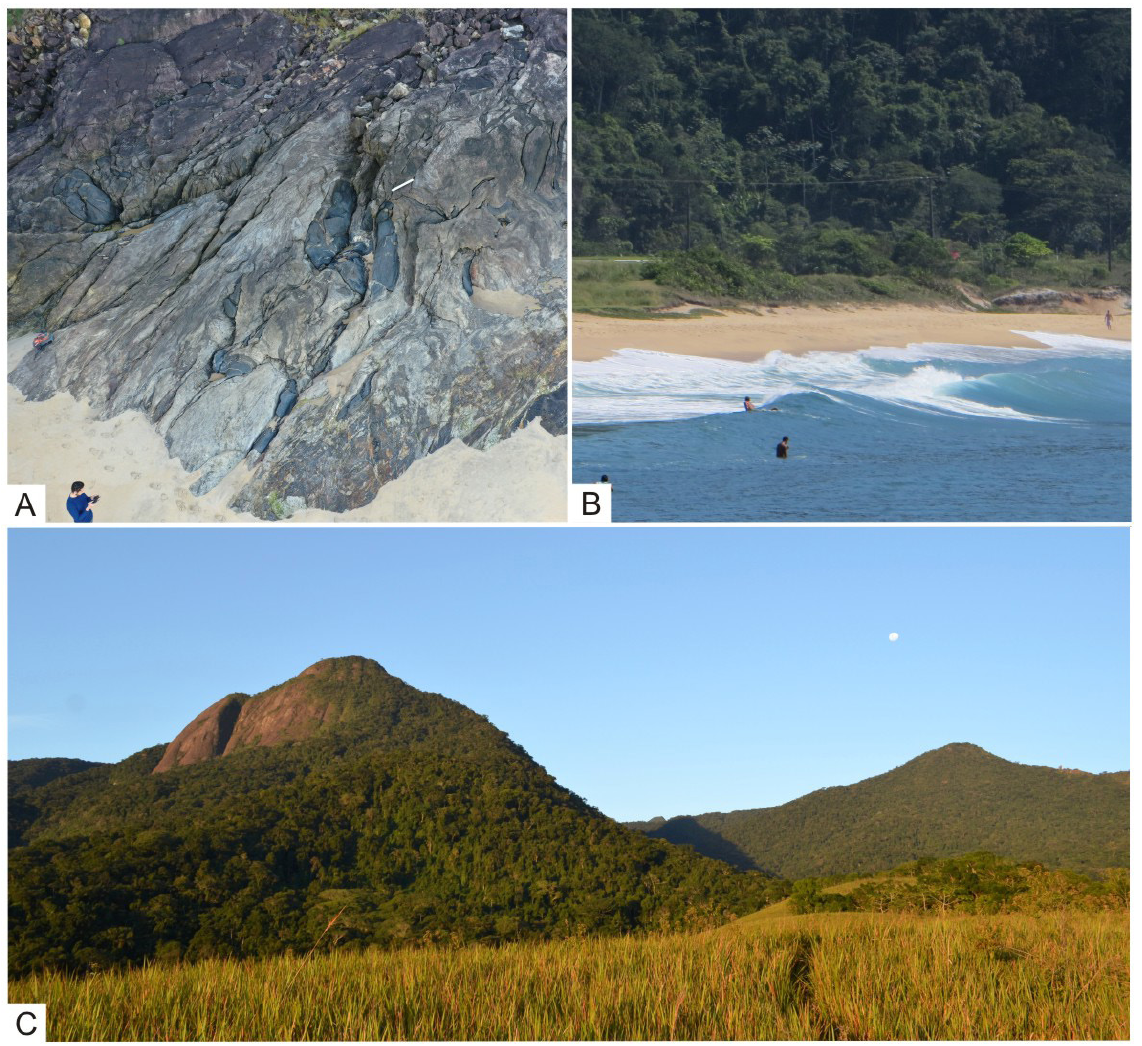
Figure 2. A) Geosite “Metatexitic Paragneisses and Amphibolites of Boiçucanga”, in São Sebastião, showing bou- dinaged and folded amphibolitic bodies; B) Geosite “Pleistocene Marine Terrace of Praia Vermelha do Norte”, in Ubatuba, with emphasis on the marine terrace with vegetation transitioning from the coastal plain to the